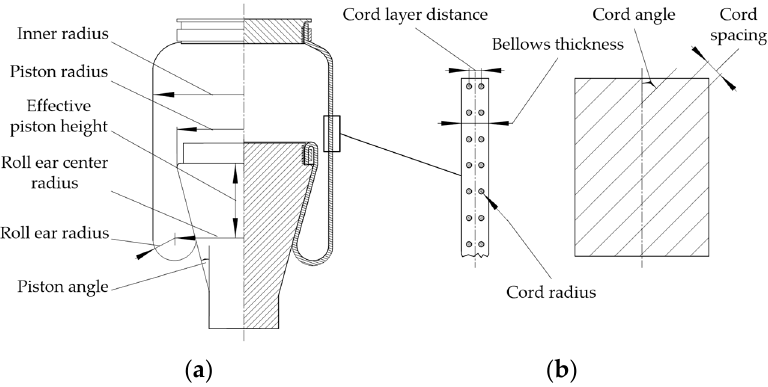
Figure 4. Structure diagram air spring. ( a ) Overall Structure ( b ) Structure of cord